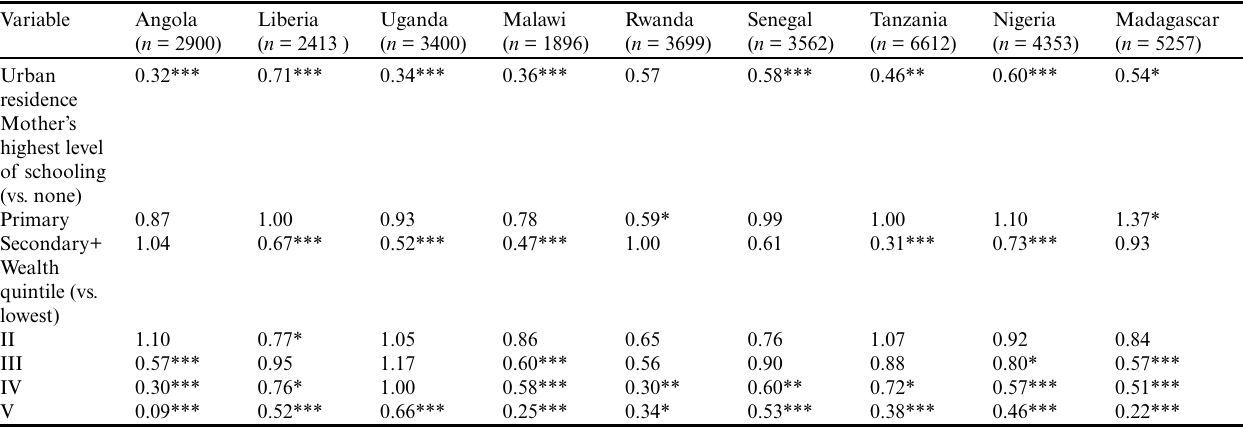
Table 5 . Odds ratios for malaria parasitemia in children from country-specific (IA) logistic regression models.